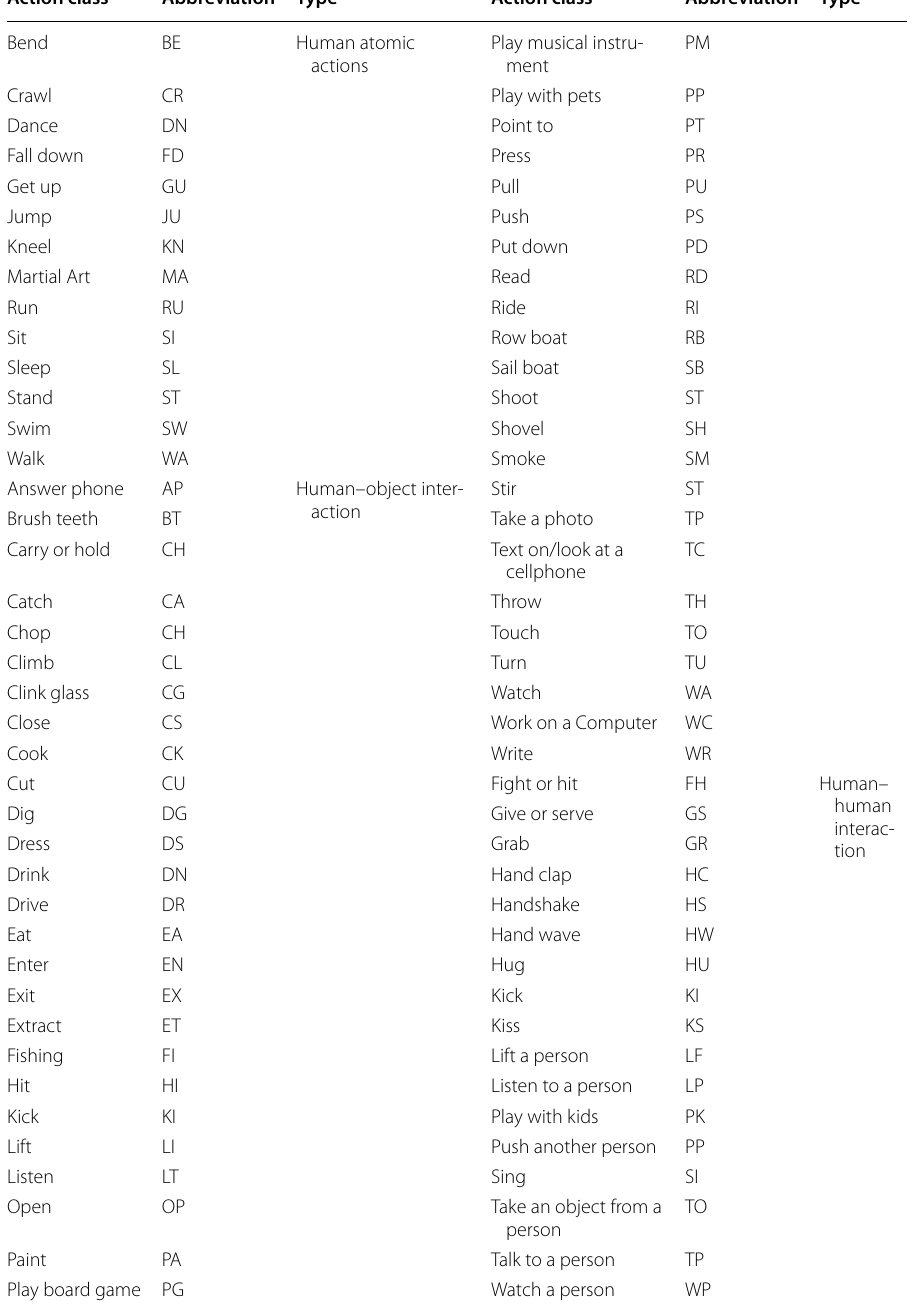
Table 4 Action class categories in AVA action dataset with abbreviation Action